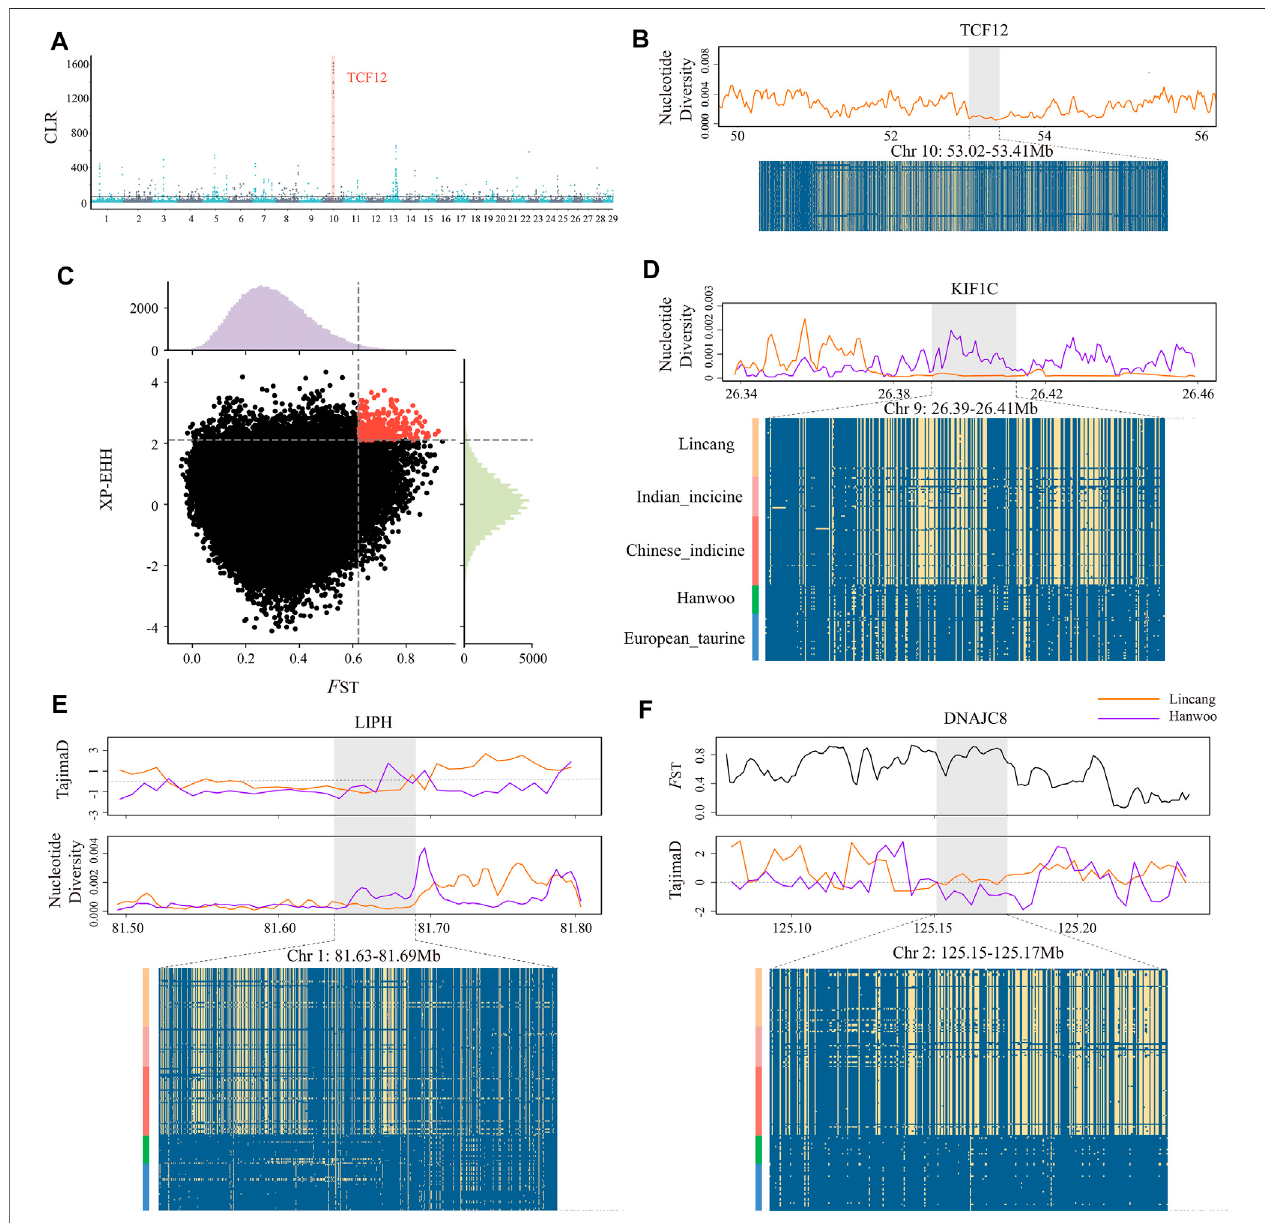
FIGURE 3 | Selective signals in Lincang cattle. (A) Manhattan plot of selective sweeps by the CLR method. The horizontal lines indicate the signi fi cance threshold (where CLR > 61) used for extracting outliers. (B) Nucleotide diversity plots and haplotype pattern heatmaps of the TCF12 gene region. (C) Distribution ofthe F ST (x axis) and XP-EHH (y axis) between Lincang and Hanwoo cattle. The dashed vertical and horizontal lines indicate the signi fi cance threshold (where F ST > 0.62 and XP-EHH > 2.1) used for extracting outliers. (D) Nucleotide diversity and degree of haplotype sharing across populations at the KIF1C gene region. (E) TajimaD, nucleotide diversity, and degree of haplotype sharing across populations at the LIPH gene region. (F) F ST , TajimaD, and degree of haplotype sharing across populations at the DNAJC8 gene region. The major allele at each SNP position is colored in yellow.